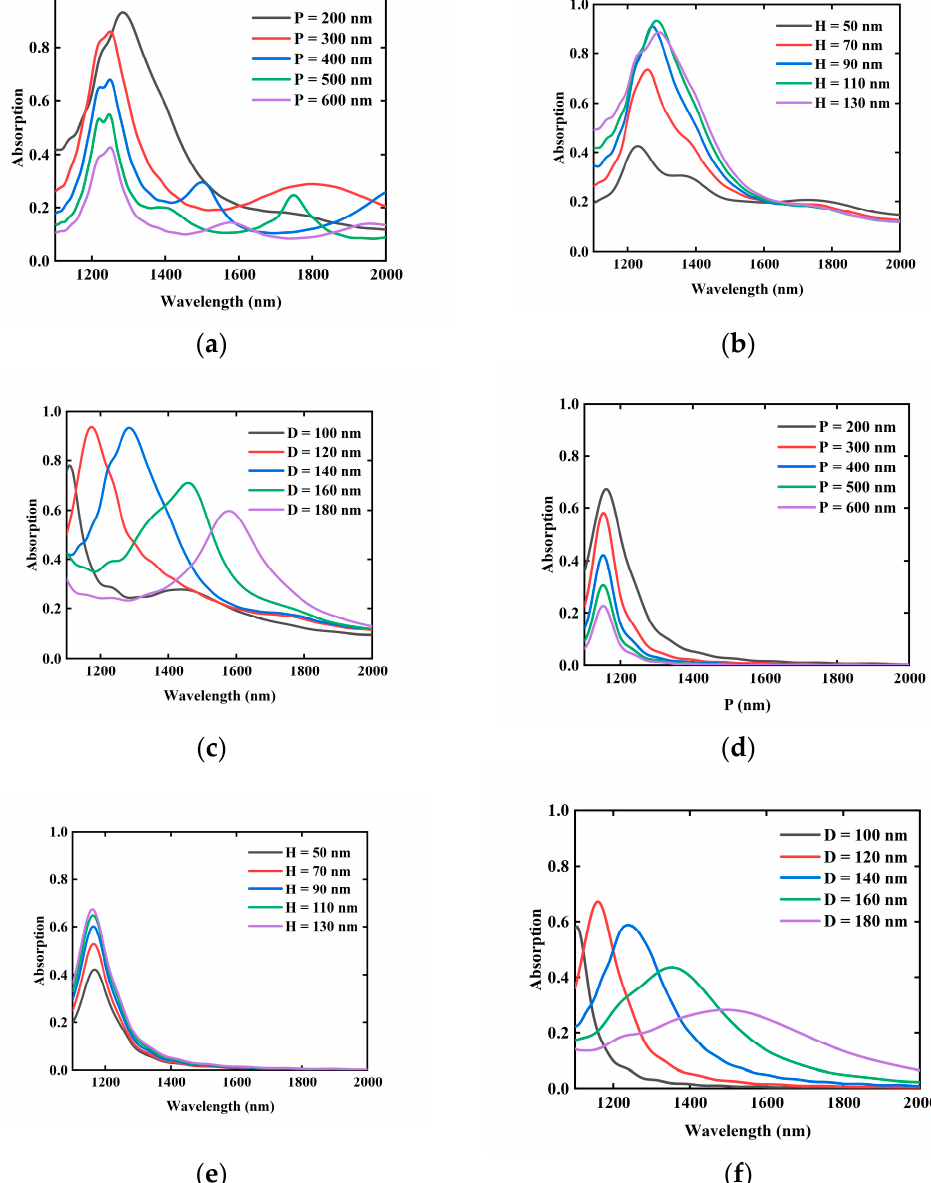
Figure 5. ( a – c ) Calculated absorption spectra of the Au/Si NP arrays/Au with a varying period, height, and diameter, respectively. ( d – f ) Calculated absorption spectra of the Au/Si NP arrays with varying periods, heights, and diameters, respectively.